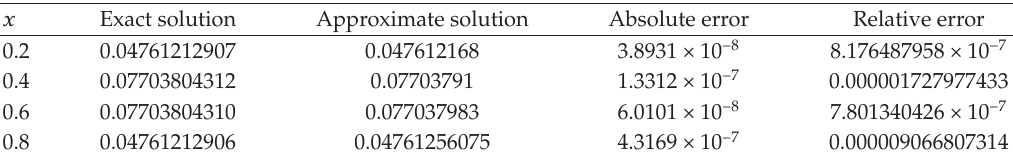
Table 3: The exact solution, approximate solution, absolute error, and relative error of Example 4.2 for initial conditions at t (cid:3) 0 . 8.